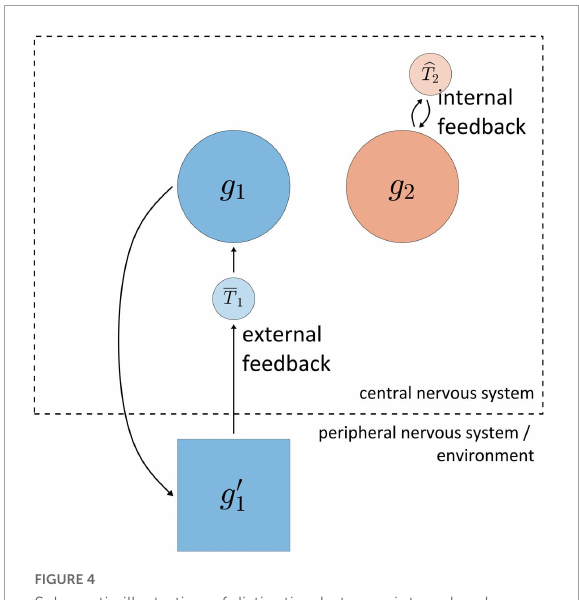
FIGURE4 Schematic illustration of distinction between internal and external feedback. The dashed line represents the boundary of the central nervous system. Systems g 1 and g 2 are gestural systems, g ’ 1 is system which represents information associated with g 1 outside of the central nervous system, and T 1 and T 2 are hypothetical systems which use feedback to act on g 1 / g 2